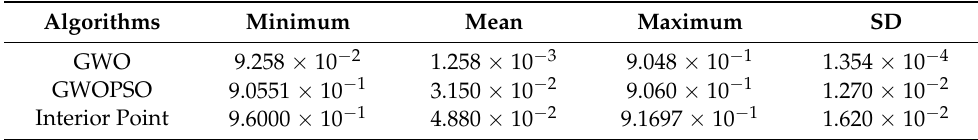
Table 9. Statistical results for relay operational time for all the algorithms.